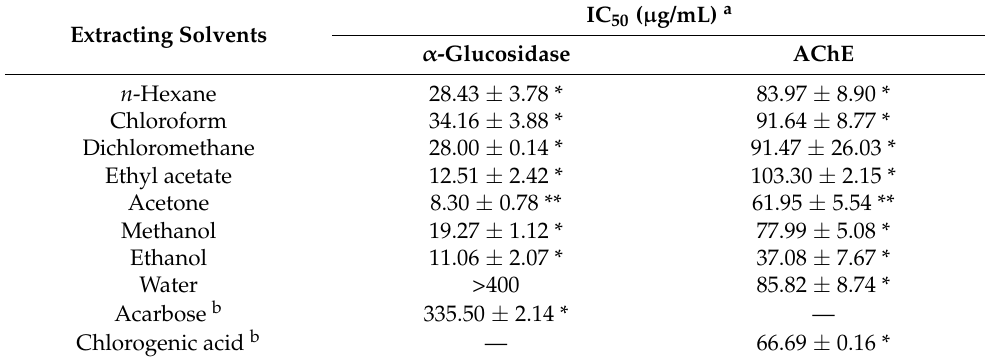
Table 3. Different solvent extracts from Ampelopsis japonica of α -glucosidase and AChEinhibitory activities. Extracting Solvents